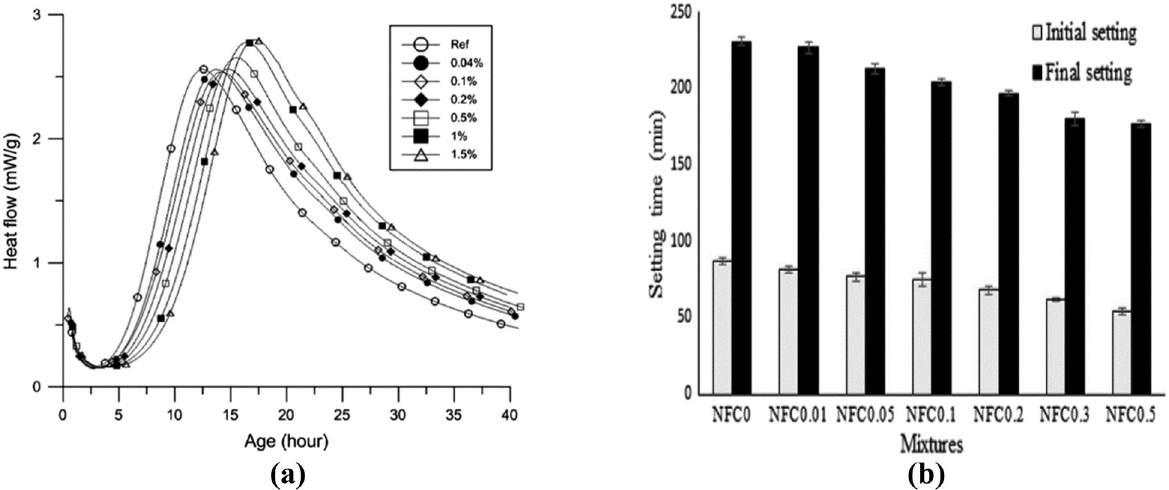
Figure 19: ( a ) Heat fl ow curves of the sulfated CNC - reinforced cement pastes for the fi rst 40 h, reprinted with permission from ref. [ 42 ] ; Copyright: Elsevier, 2015; ( b ) setting time of carboxylated NFC - reinforced cement pastes, reprinted with permission from ref. [ 41 ] ; Copyright 2017, SAGE